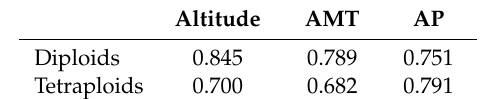
Table 5. Moran’s I values of epiloci for cytotypes in correlation to observed environmental parameters. Altitude